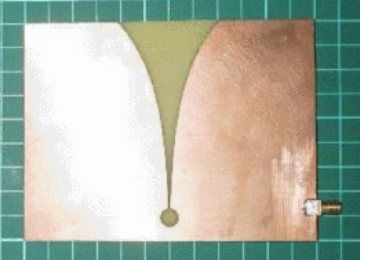
Figure 3. Vivaldi antenna used in the proposed radar system [45].